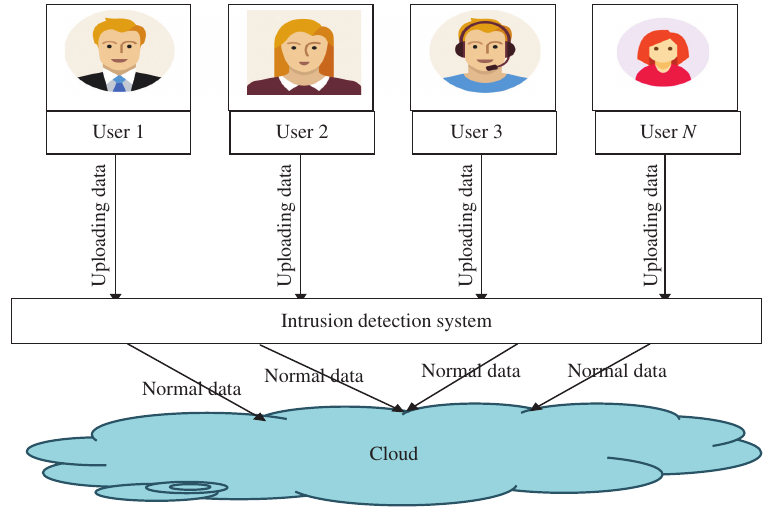
Figure 3: Testbed of the Proposed